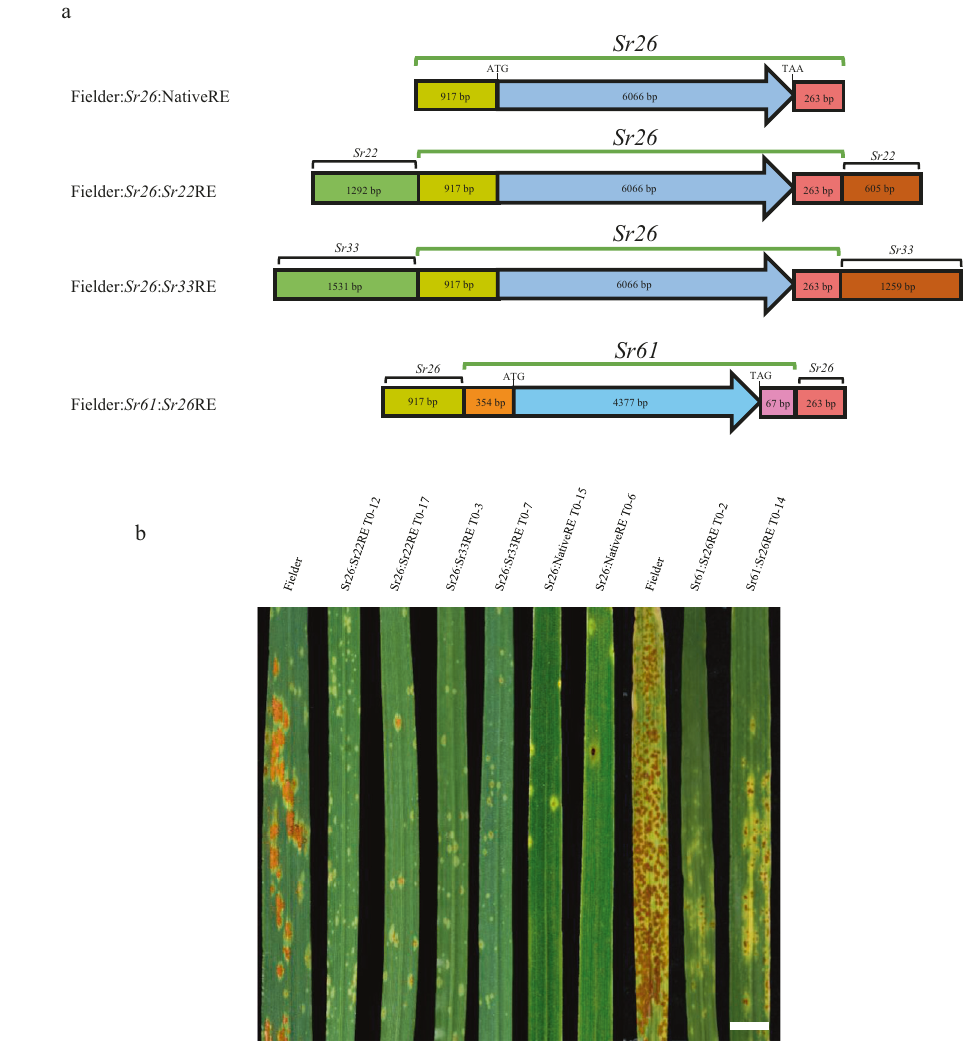
Fig. 2 Validation of the Sr26 and Sr61 candidate genes by transformation. a Four constructs used for wheat transformation. The three Sr26 constructs encoded the Sr26 gene candidate and either its native regulatory sequences ( Sr26:NativeRE ), regulatory sequences from Sr22 ( Sr26:Sr22RE ) or regulatory sequences from Sr33 ( Sr26:Sr33RE ). A single construct was used for the Sr61 gene candidate under the regulatory control of Sr26 5 ′ and 3 ′ regulatory elements (REs). 5 ′ REs and 3 ′ REs are indicated by black brackets with sizes in bp indicated for all four constructs. Sr26 and Sr61 intron/exon coding regions are shown as light and dark blue arrows. b Phenotypic responses of representative T 0 plants produced for all four constructs and inoculated with Pgt race 98-1,2,3,5,6 + Sr50 along with non-transgenic Fielder control lines. All lines except the susceptible Fielder control showed low infection types. Photographed 12 days of post-inoculation. Bar shows 1